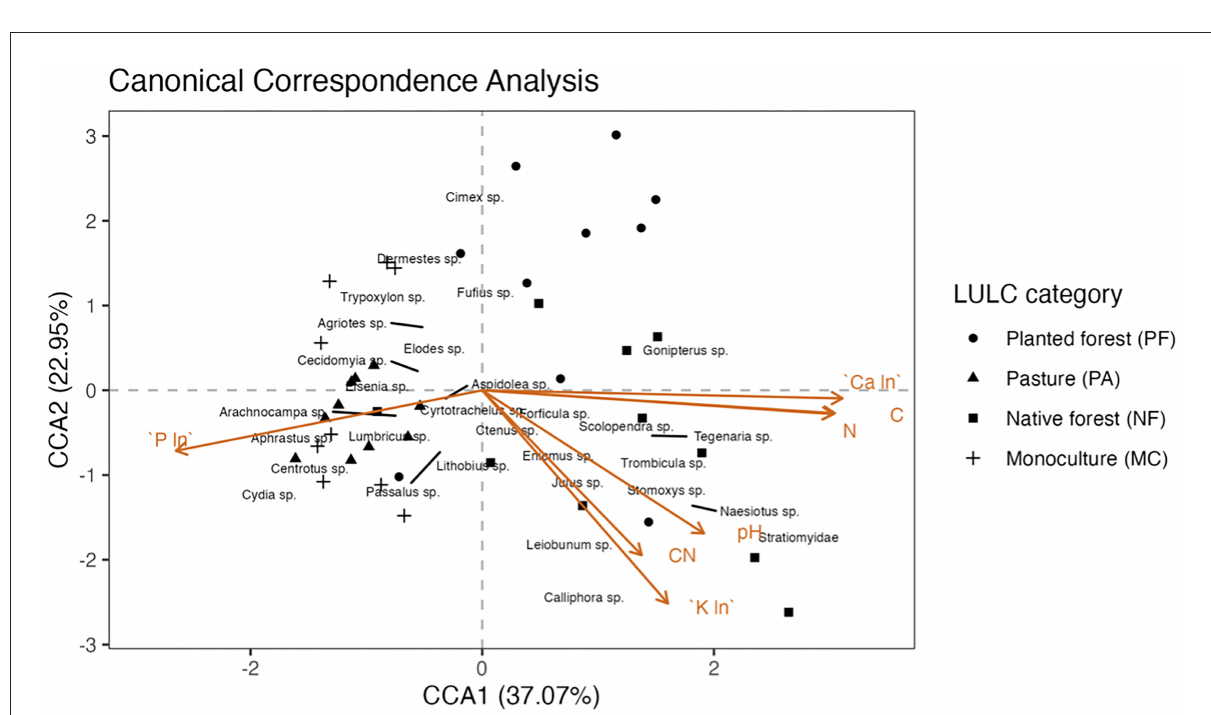
FIGURE7 Canonical correspondence analysis of the soil chemical parameters and the relative abundance of the edaphic macroinvertebrate community. Significant parameters: ***Org carbon, **pH, K(ln), *C:N, P(ln). Asterisks illustrate the power of the levels of significance of the statistical test: * p ≤ 0.05; ** p ≤ 0.01; *** p ≤